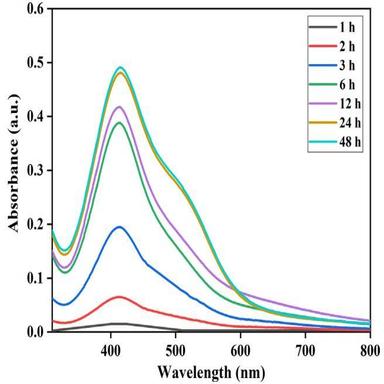
Dressing pH of GLT film, GLT/Neem extract film, and GLT/Neem extract NCP film.